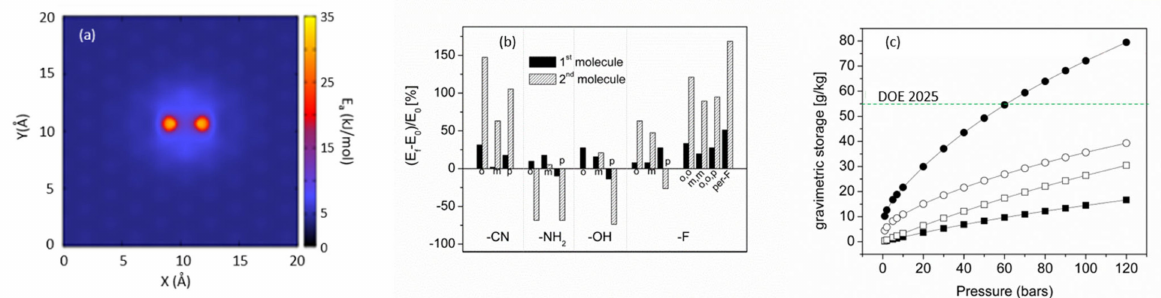
Figure 7. ( a ) Energetic landscape of infinite graphene surface substituted by two Be 2 dimers separated by two carbon atoms; ( b ) variation (%) of energy of H 2 adsorption over the Be 2 dimer in functionalized Be 2 -benzene. E 0 is the binding energy of H 2 adsorbed on non-functionalized Be 2 -benzene: E 0 (1st H 2 ) = 21 kJ/mol, E 0 (2nd H 2 ) = 8 kJ/mol, (o)—ortho, (m)—meta, (p)—para position of the functional group with respect to Be 2 dimer; (per-F) stands for per-fluorinated Be2-benzene; ( c ) hypothetical RT storage capacity in porous carbon with SSA = 5000 m 2 /g and the pore width of 1.1 nm: open squares-all carbon structure, open circles—25% of carbon sites substituted by Be 2 dimers, close circles—25% of carbon sites substituted by Be 2 dimers, 25% showing enhanced adsorption energy due to functionalization of pore edges; black squares—the RT storage capacity in infinite graphene-based slit-shaped pores of the same